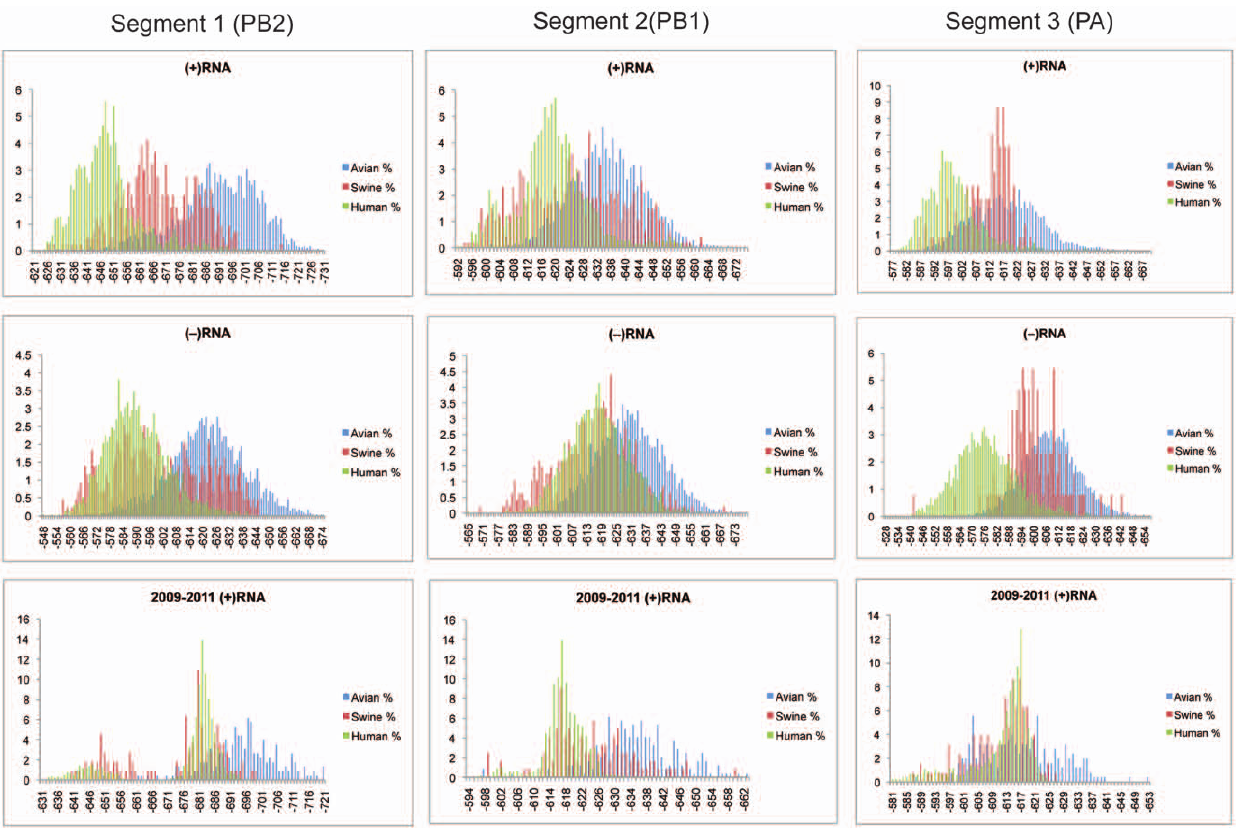
detailed predicted free energies for segments 4 and 6 are shown in Figure 4. The average free energies were more stable in the ( + )RNA than the ( 2 )RNA for all three species (Table 2). The distributions for the ( + )RNA were more distinct for each of the